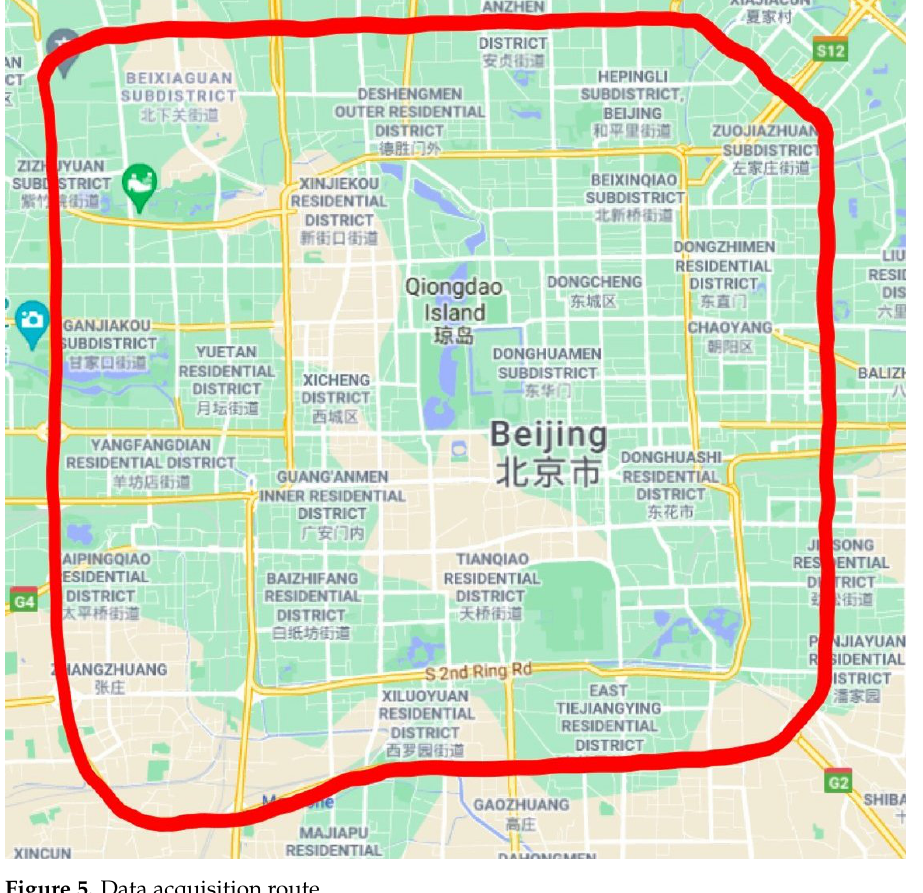
Figure 5. Data acquisition